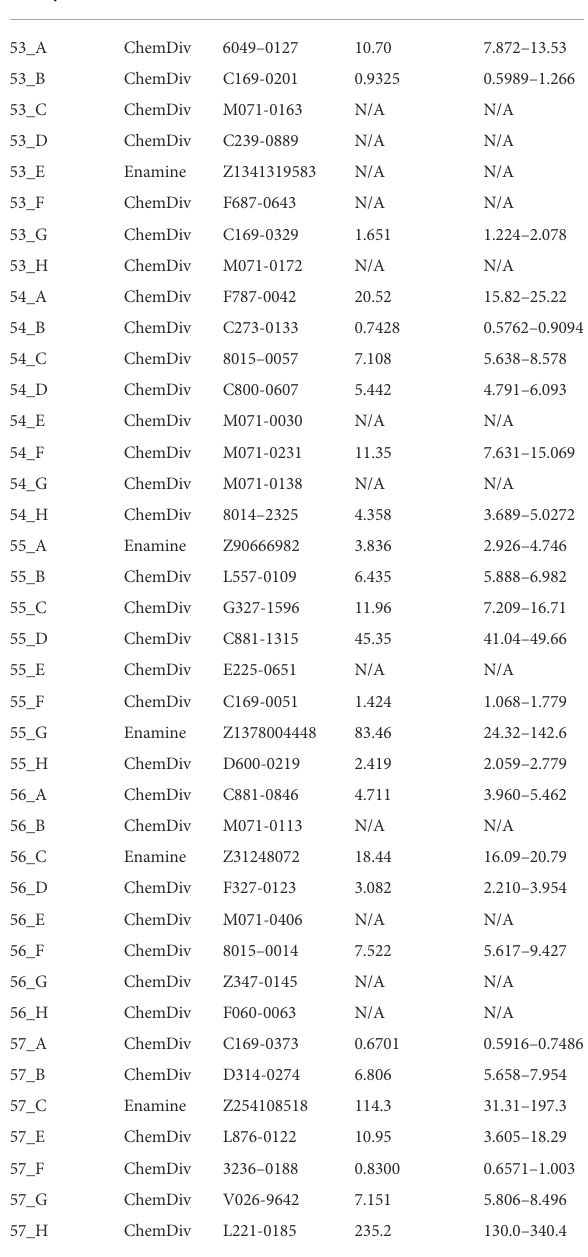
TABLE 2 The IC50 of the top 40 hit compounds from the HTS were analysed by FMP assay ( n = 6). Assay